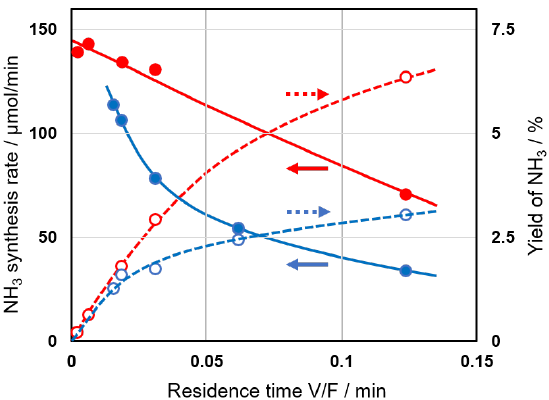
Figure 8. Dependence of the synthesis rate (closed) and yield (open) of ammonia on the residence time (V / F) of the reactants gases using Al 2 O 3 (SC) (blue) and 5Ni / Al 2 O 3 (KC, 773) (red) catalysts. Reaction conditions: applied voltage, 6 kV; frequency, 50 kHz; electrode length, 25–150 mm; volume of reaction port (V), 0.515–3.09 mL (the volume was calculated based on the degree of void space (0.52) and the volume of catalyst bed); total flow rate (F), 25–200 mL min − 1 ; H 2 / N 2 =